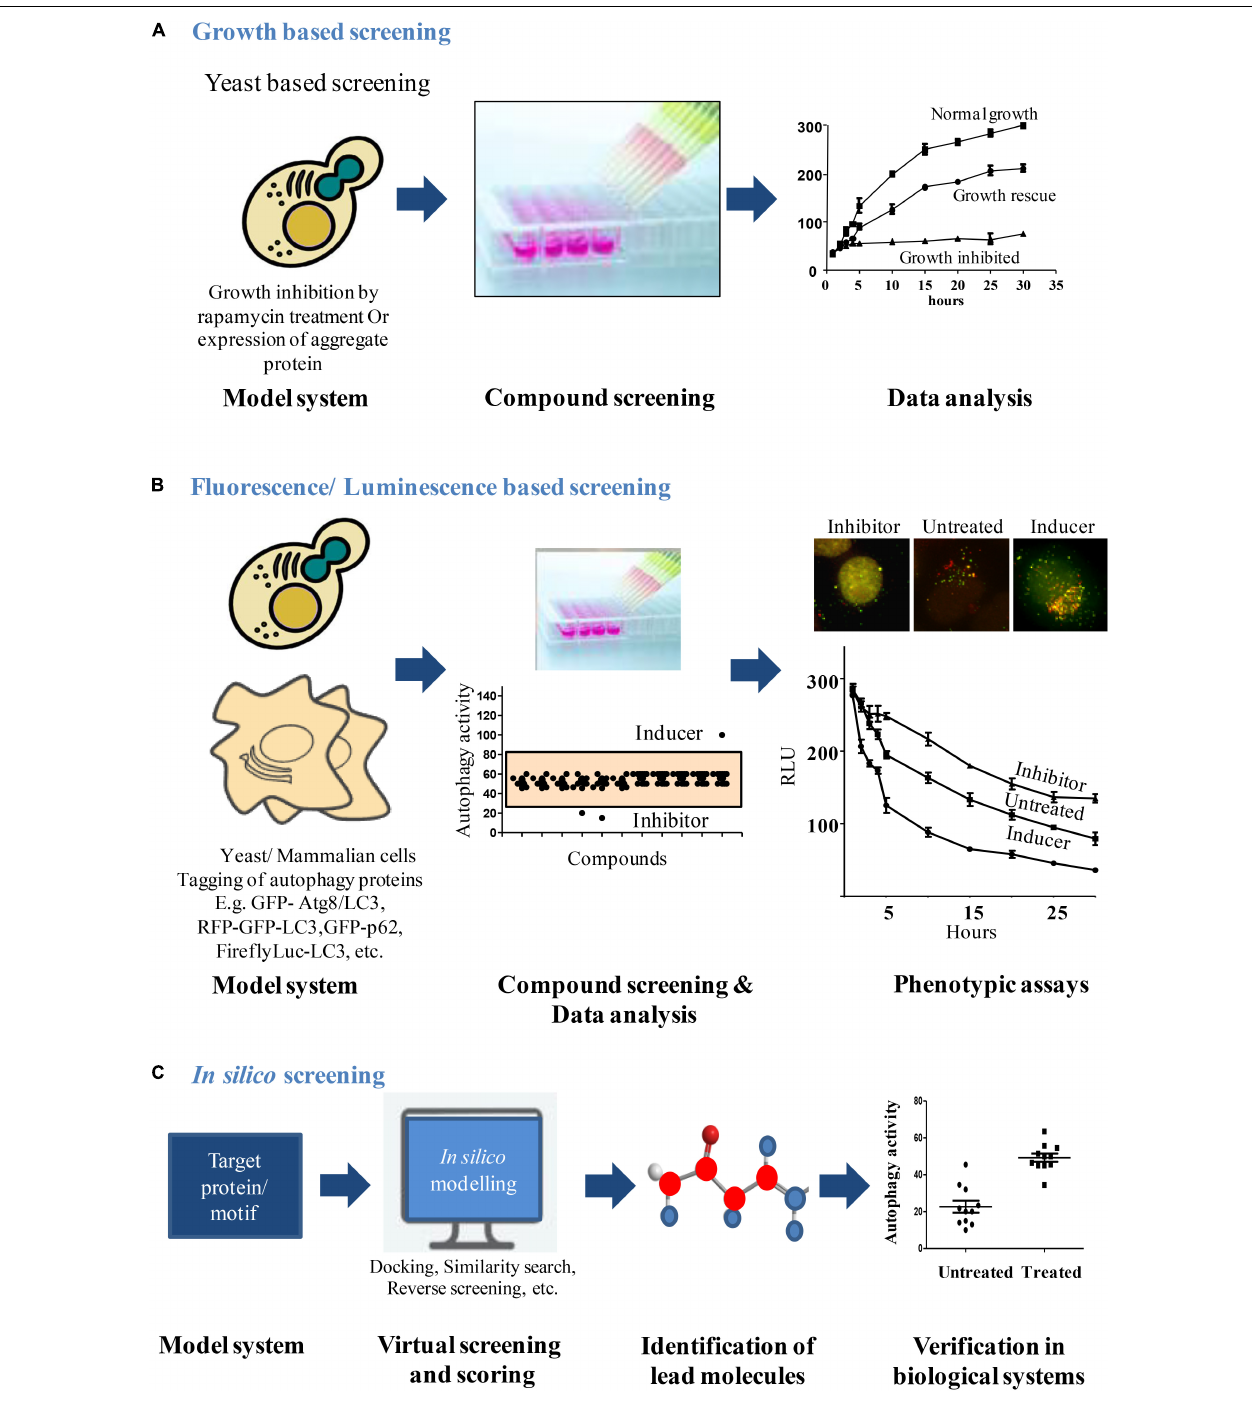
FIGURE 1 | Workflow for screening autophagy modulators. (A) Growth based screening: growth inhibition can be induced in yeast due to over expression of aggregate proteins or rapamycin treatment. This cytostatic effect exhibited by yeast can be used as a platform to screen compounds that rescue the growth lag through autophagy induction. After compound treatments, analysis of yeast growth curves identifies the compounds that rescued the growth lag. (B) Fluorescence/Luminescence based screening: fluorescent or luminescent reporters are tagged to autophagy proteins for transfection in yeast or mammalian model systems. Modulators of autophagy from chemical libraries are obtained by analyzing the fluorescent/luminescent signal intensities or by visualizing the autophagic vesicle formation by microscopy. (C) In silico screening: structures of autophagy proteins/motifs of interest can be obtained from data sources like Protein Data Bank and can be used as a model system to identify chemical molecules that bind using in silico modeling softwares. The selected lead molecules are then verified in biological system to validate its ability to modulate the process.